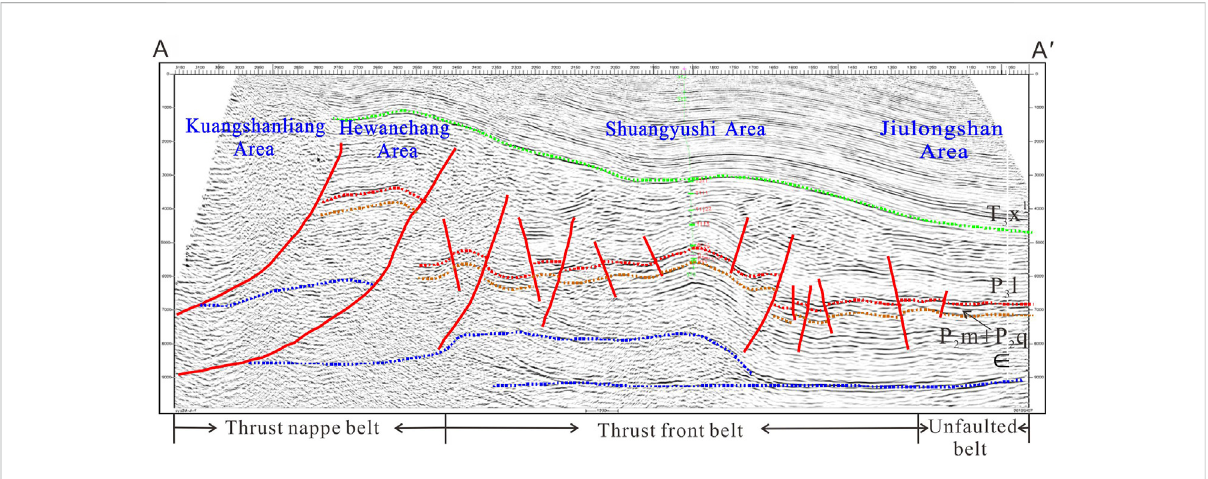
FIGURE 3 A seismic pro fi le in the NW direction of the Northwestern Sichuan Basin to show the distribution of thrust faults and the uplift of formations in different areas Figure 1 for pro fi le